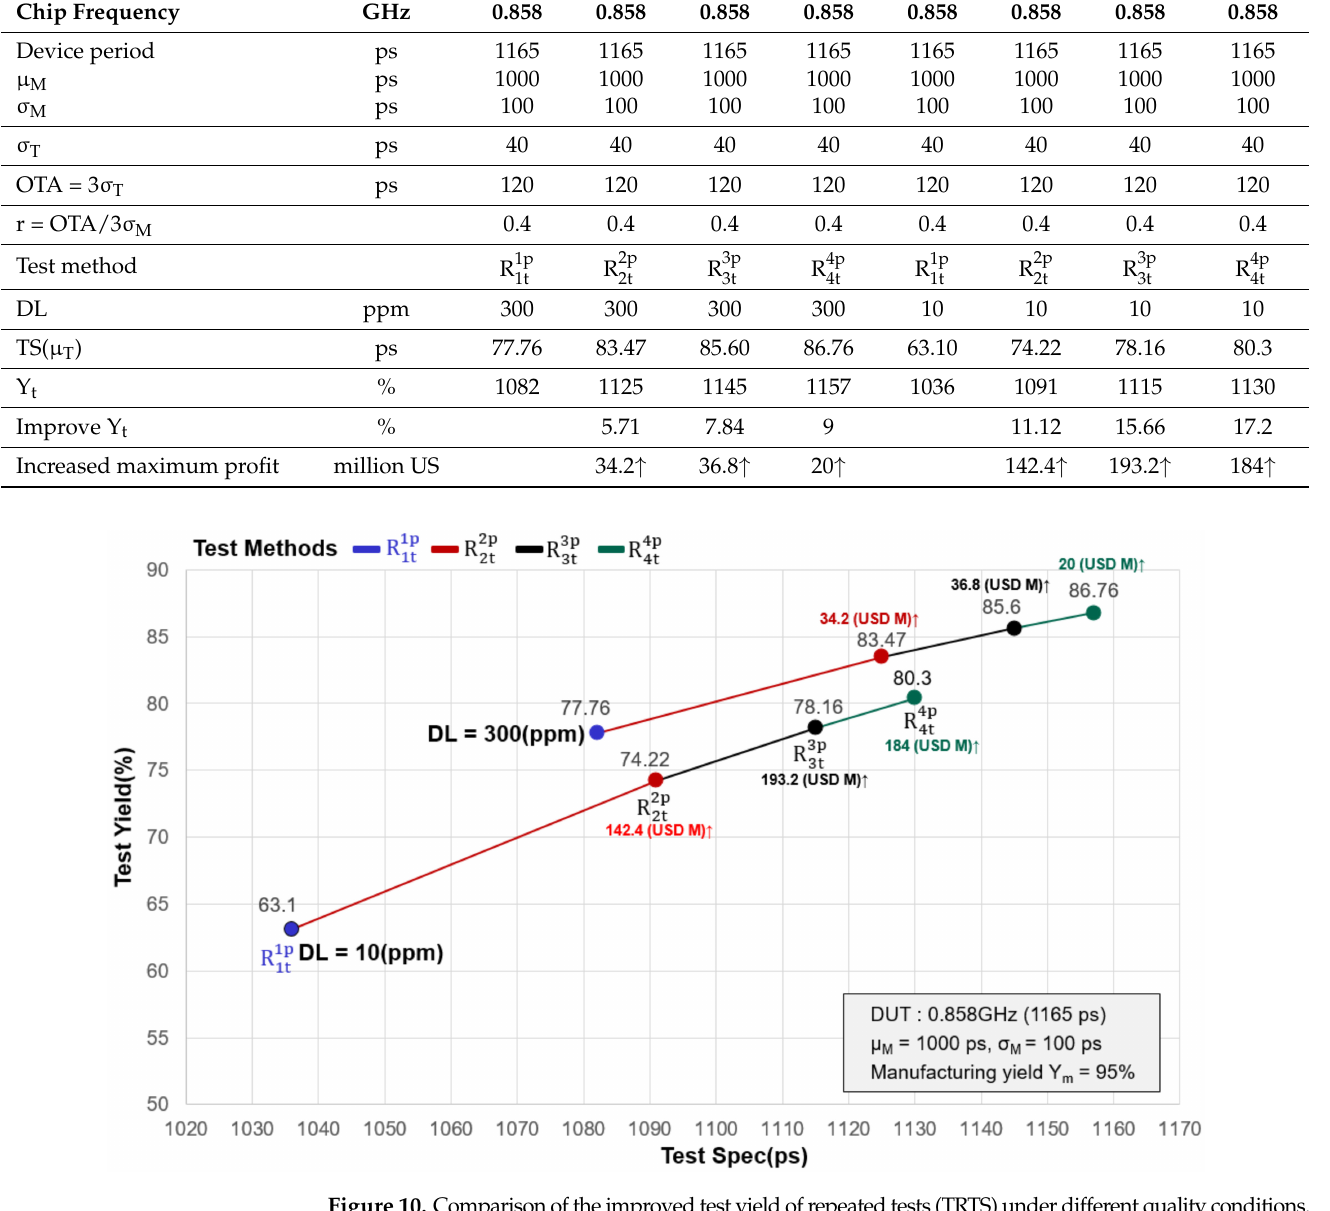
Table 2. The results of the test depend on the different test methods and the number of tests.